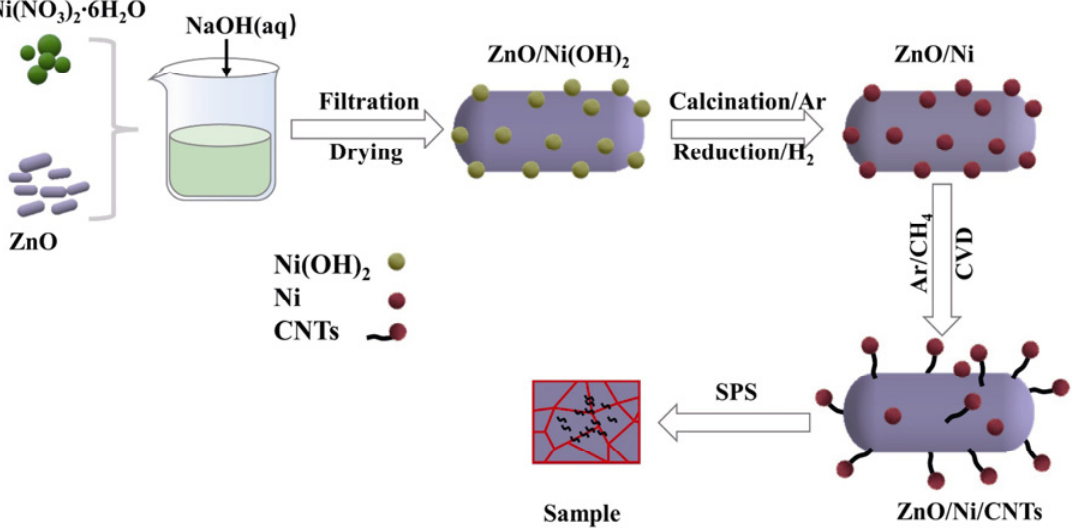
Fig. 1 Schematic illustration of the synthesis